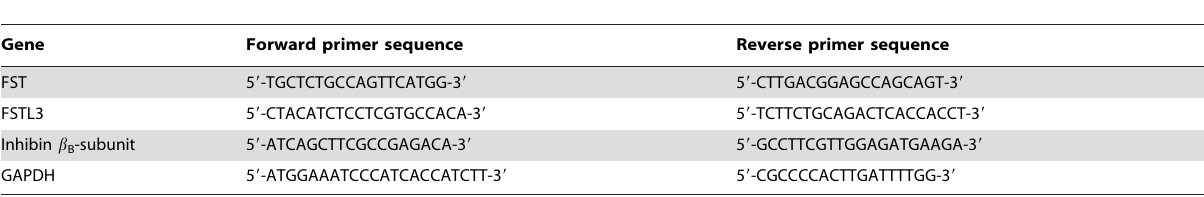
Table 1. Nucleotide sequences of primers used for quantitative real-time PCR.